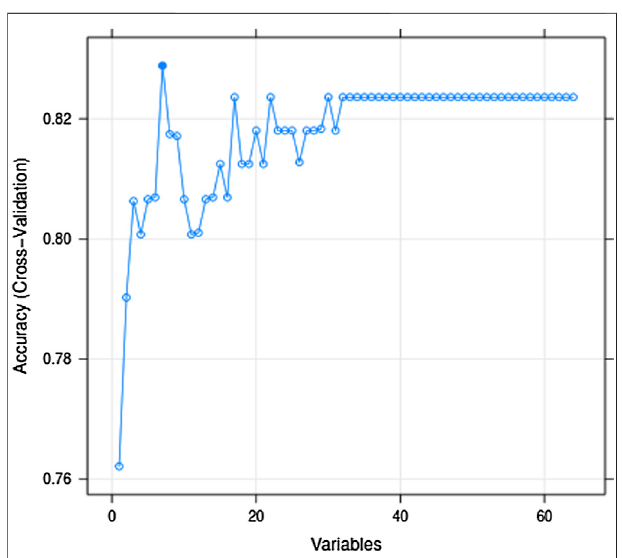
FIGURE 1 | Relationship between the accuracy and the number of variables after cross-validation.